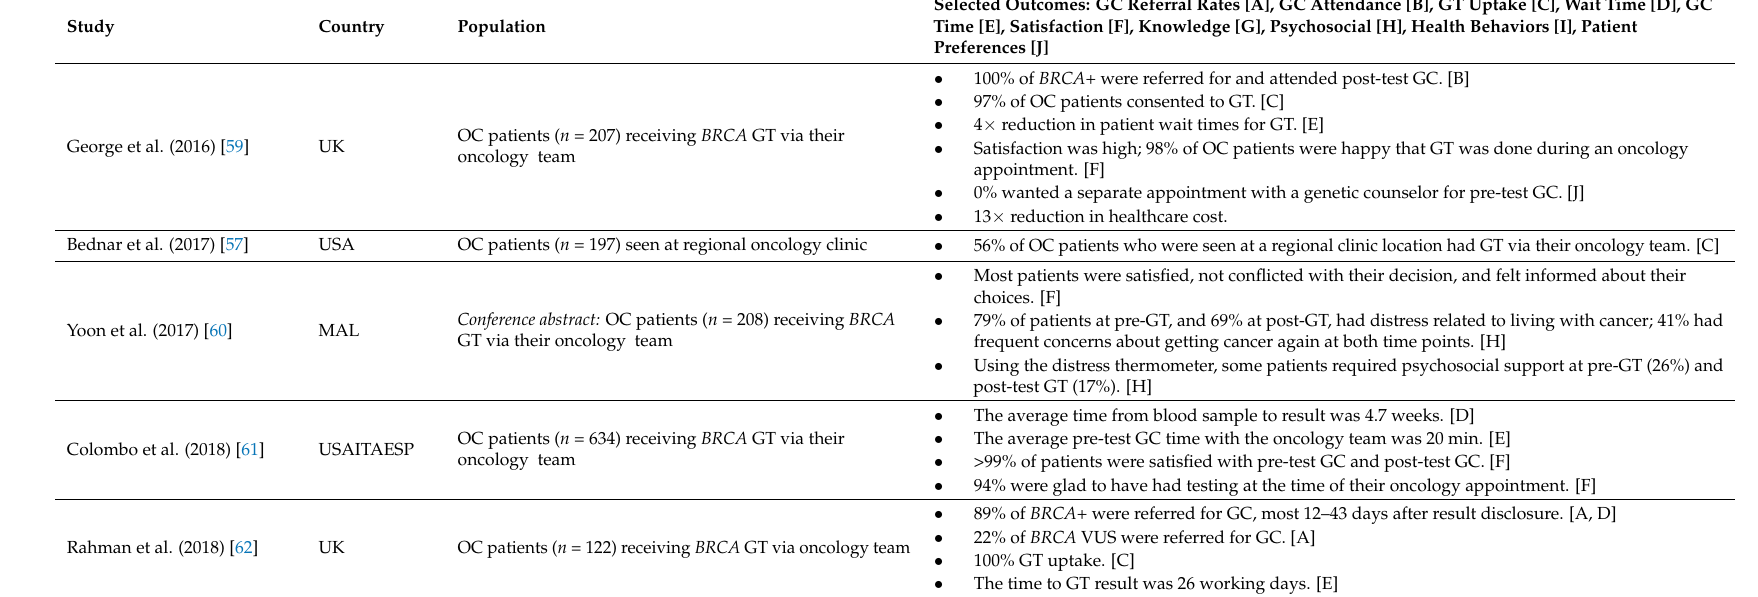
Table 5. Mainstreaming genetic testing